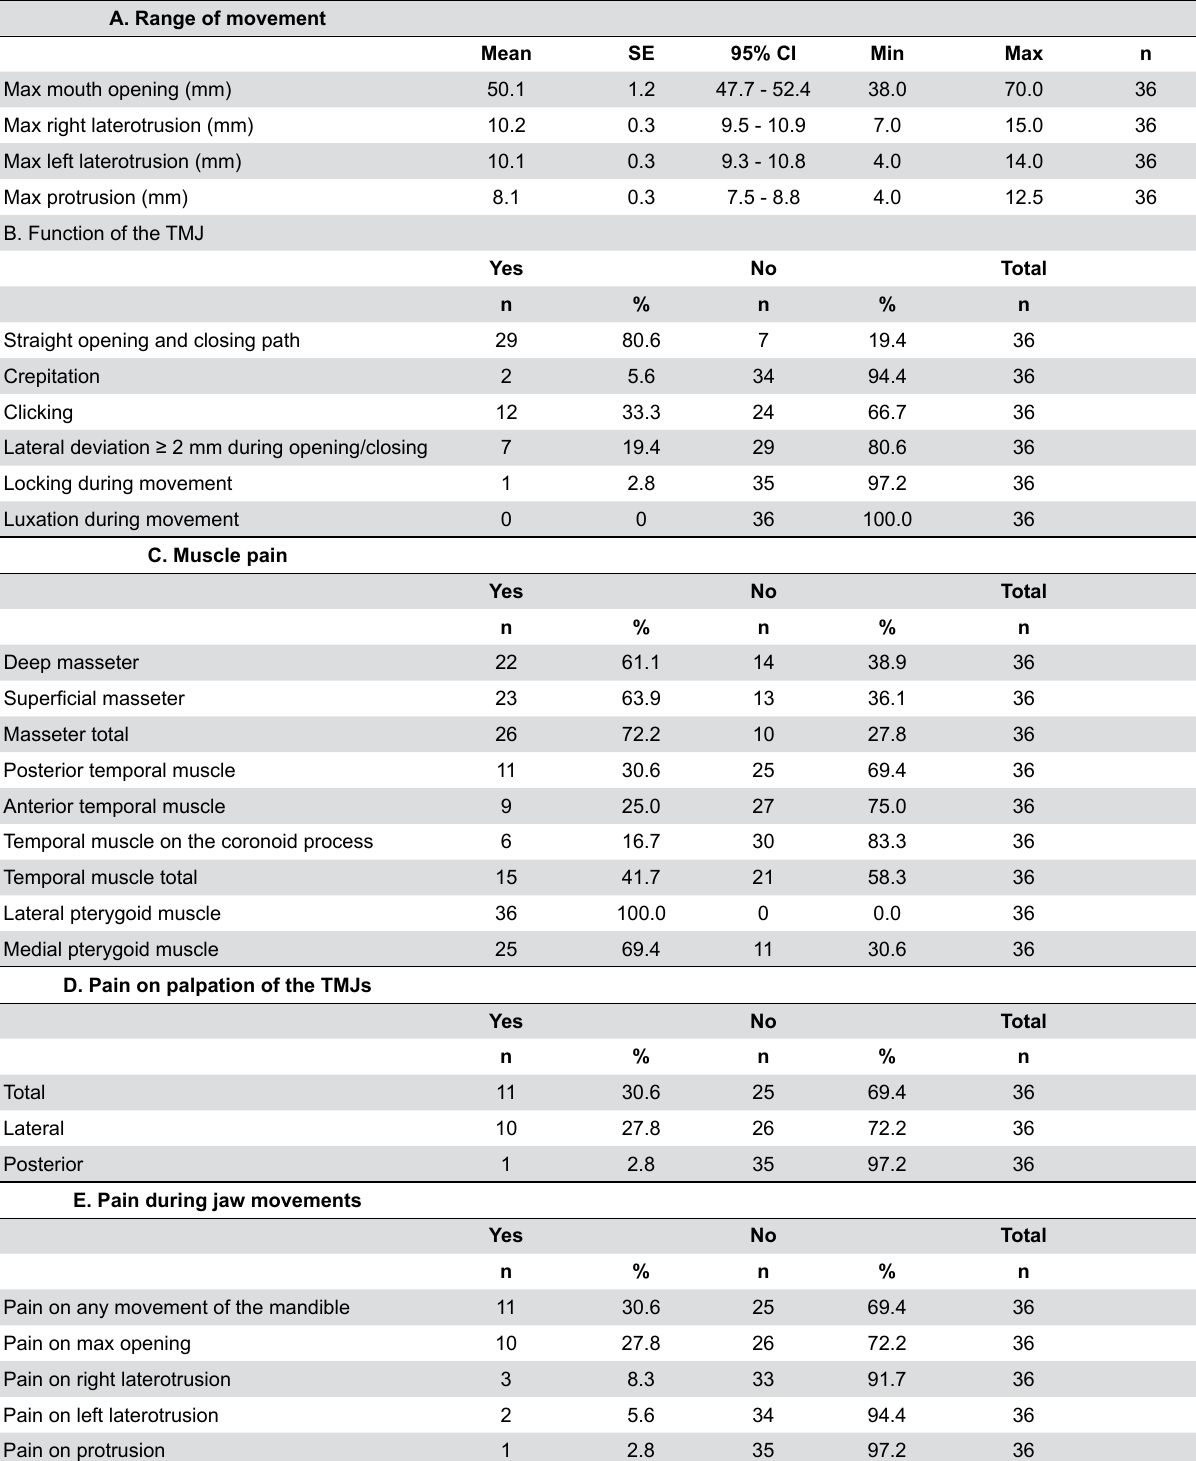
Table 2- Results from clinical examination 10-15 years after surgery listed according to Helkimo clinical dysfunction